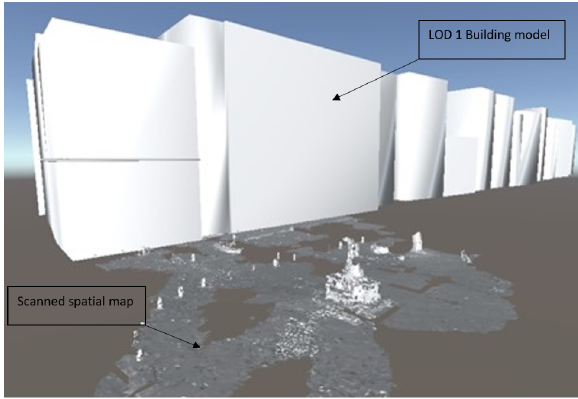
Figure 2. Occlusion mask based on the geometry of the scanned Spatial Map and 3D building model.